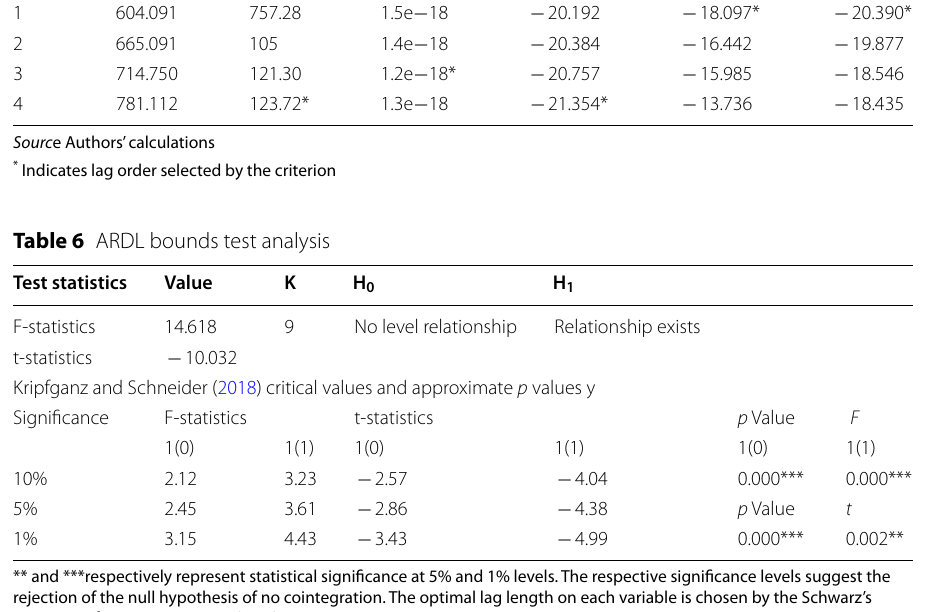
Table 5 Lag length criteria Lag LogL LR FPE AIC